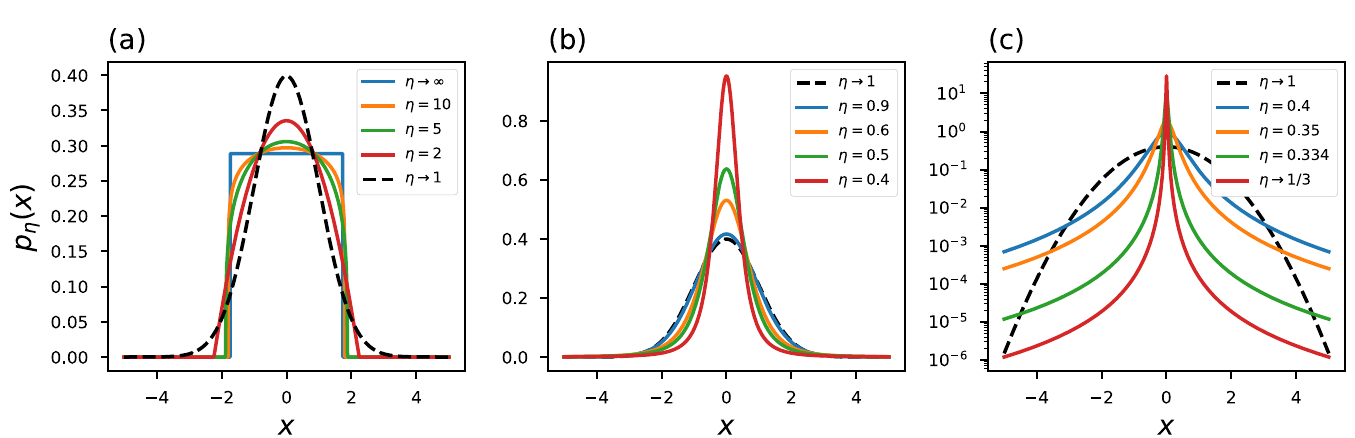
Fig 2. η -Gaussian probability distribution. The black dashed line represents the conventional